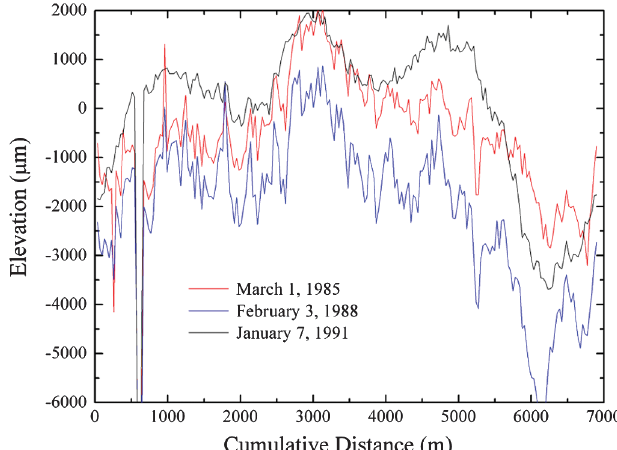
FIG. 15. (Color) Displacements of the CERN’s Super Proton Synchrotron magnets measured in 1985, 1988, and 1991 along the circumference ring; the point at 0 m placed close to the point at 6912 m (data courtesy of Jean-Pierre Quesnel of the CERN’s Survey